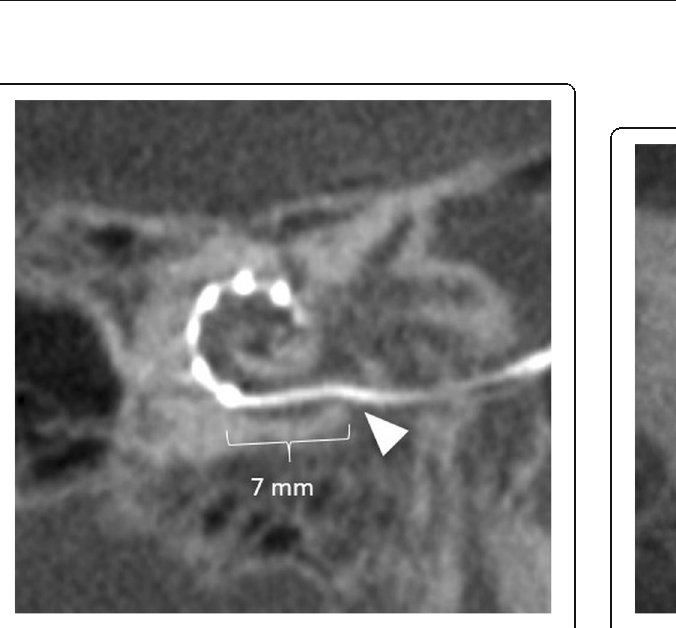
Fig. 27 A 66-year-old female patient, with underinserted electrode. CBCT paraaxial maximum intensity projection image shows extracochlear location of electrode contacts 9 to